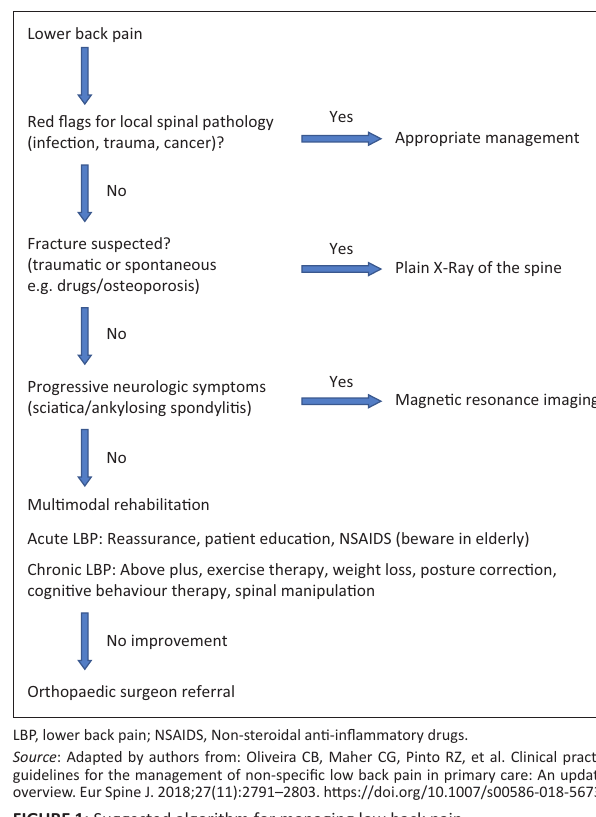
FIGURE 1: Suggested algorithm for managing low back